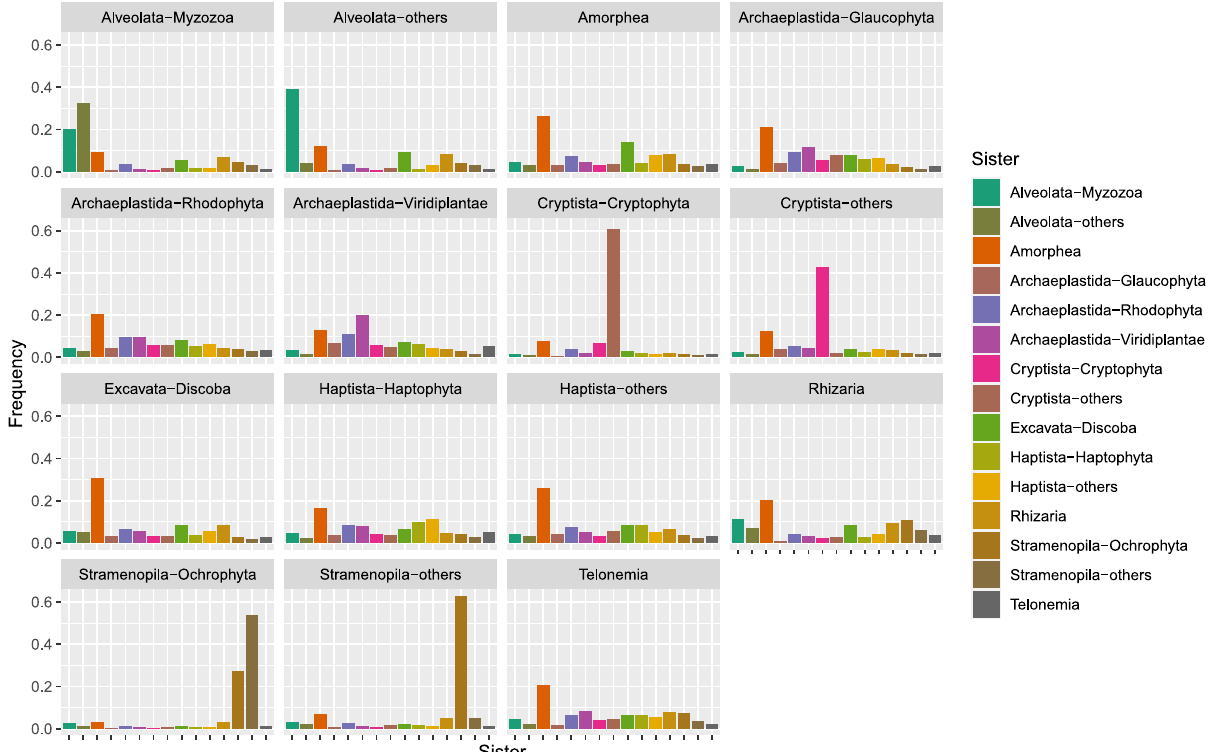
Fig. 2 Test for endosymbiotic gene transfers in red plastid-containing lineages based on the analysis of 320 single-gene ML trees. For each clade in the ML tree to which a single taxonomic label could be assigned, relative frequencies with which all other clades in the tree were recovered as the closest sister group are given (for details, see ‘ Methods ’